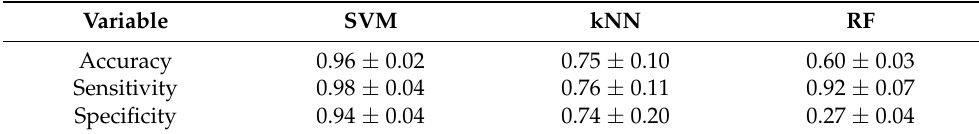
Table 4. Performance metrics for each classifier, FARSEEING test set for non-overlapping approach (0% overlapping epochs). All classifiers have been trained on a SisFall set and evaluated using a FARSEEING test set, from which the metrics have been calculated. SVM achieved the best results with the highest classification metrics. The values are mean ± standard deviation.